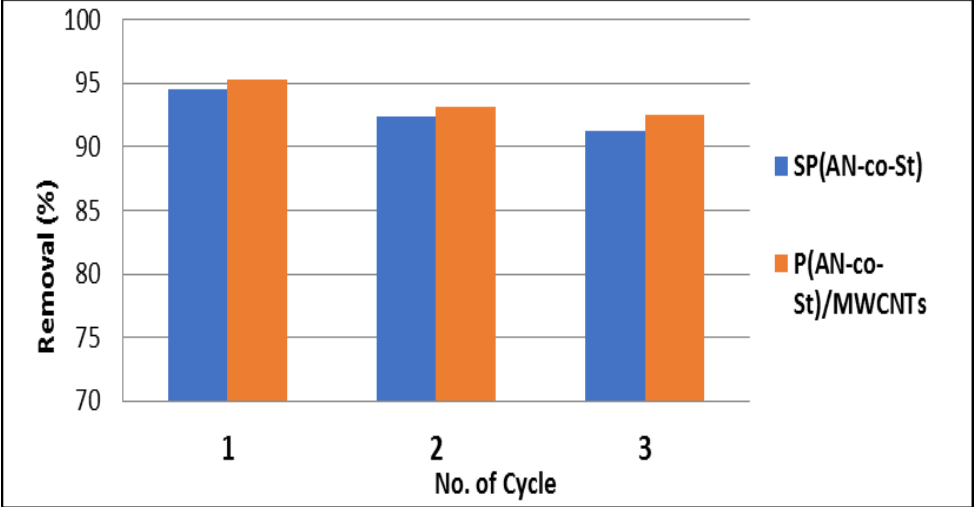
Figure 16. Reusability study of MO dye by SP(AN- co -St) and P(AN- co -St)/MWCNTs.